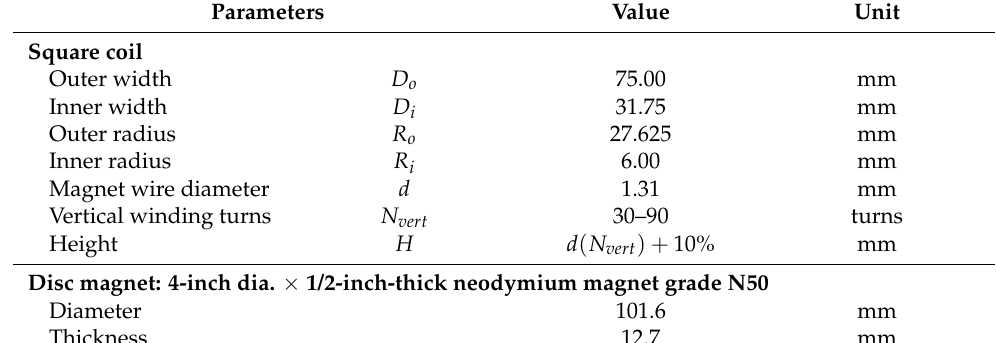
Table 2. Simulation (II): parametric simulation of the force between a square coil and a single disc magnet.